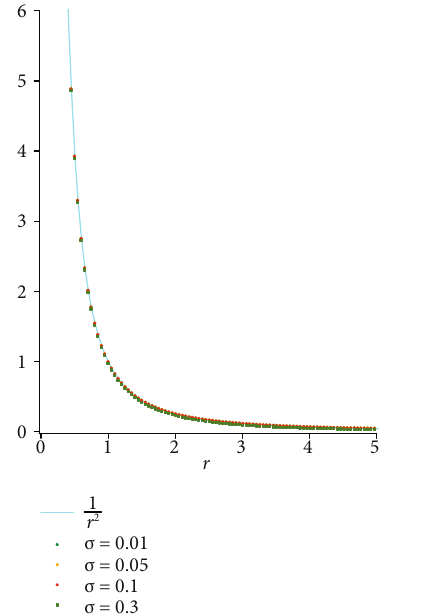
Figure 1: Plot of 1/ r 2 and its approximation in Equation (10) with σ = 0 : 01 , 0.05, 0.1, and 0.3.